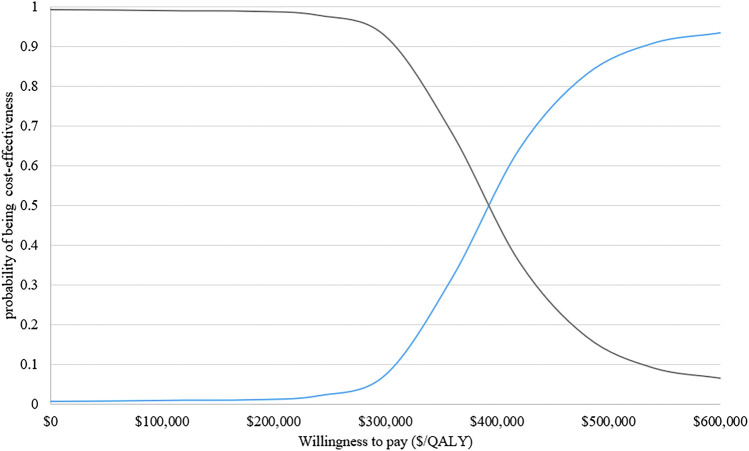
Cost-effectiveness acceptability curves of D-VMP vs. VMP. QALY: quality-adjusted life-year; D-VMP: daratumumab plus bortezomib, melphalan and prednisone; VMP: bortezomib, melphalan and prednisone.